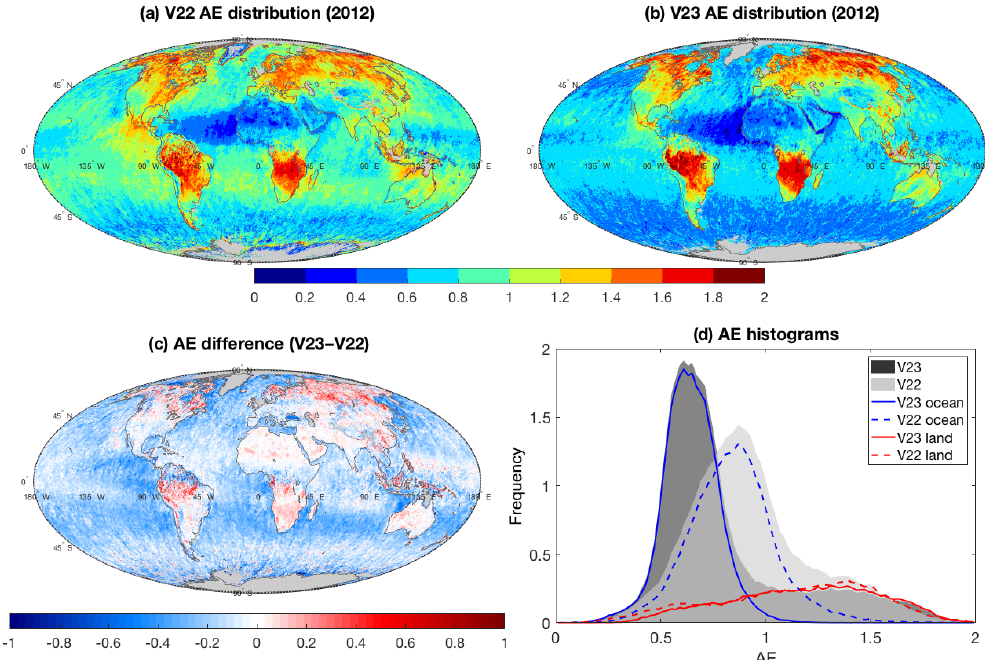
Figure 9. As in Fig. 7 except for the MISR-retrieved AE. AOD weighting is applied in AE averaging at each grid box.